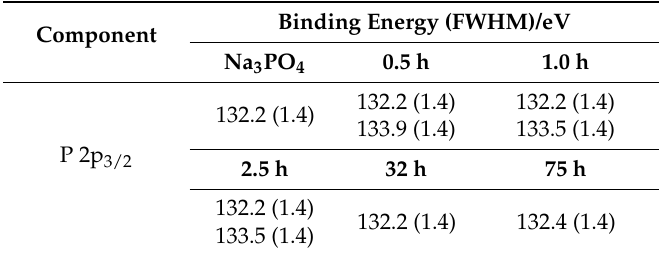
Table 2. The binding energies and peak widths (FWHM) of P 2p 3/2 components.